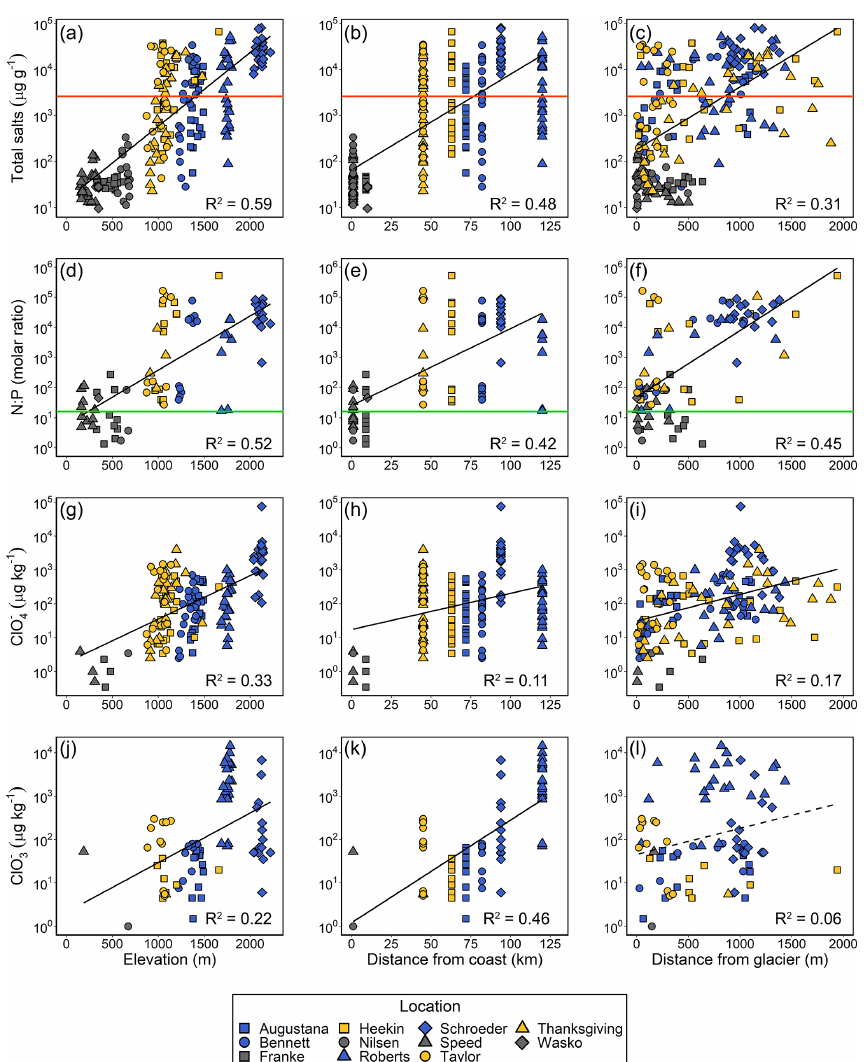
Figure 2. Total water-soluble salts, water-soluble N : P molar ratio, and ClO − tion, distance from the coast, and distance from the glacier for samples from the three geographic zones (blue for upper, yellow for middle, gray for lower zones). Linear regression lines are plotted, for which dashed lines represent regressions where p> 0 . 05 with a Bonferroni correction, and R 2 values are reported for each relationship. The horizontal orange lines represent nematode salt tolerance of ∼ 2600 (Nkem et al., 2006), and the green lines represent the Redfield ratio, N : P = 16, for phytoplankton in the